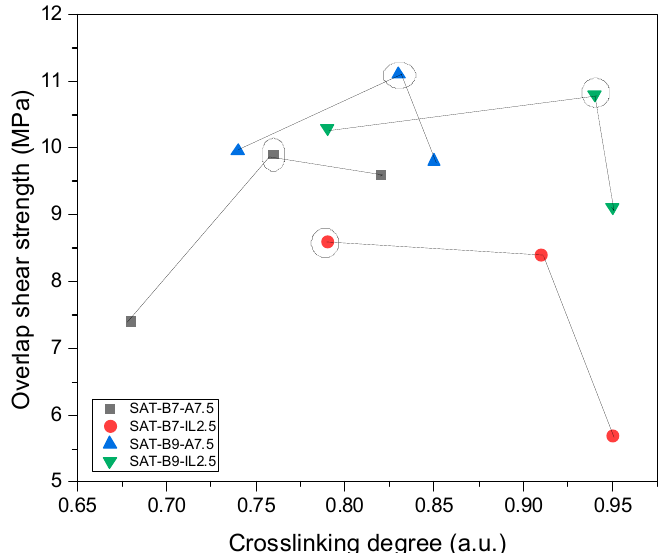
Figure 12. Dependence of the overlap shear strength of Al/SAT/Al joints on the cross-linking degree of SATs.